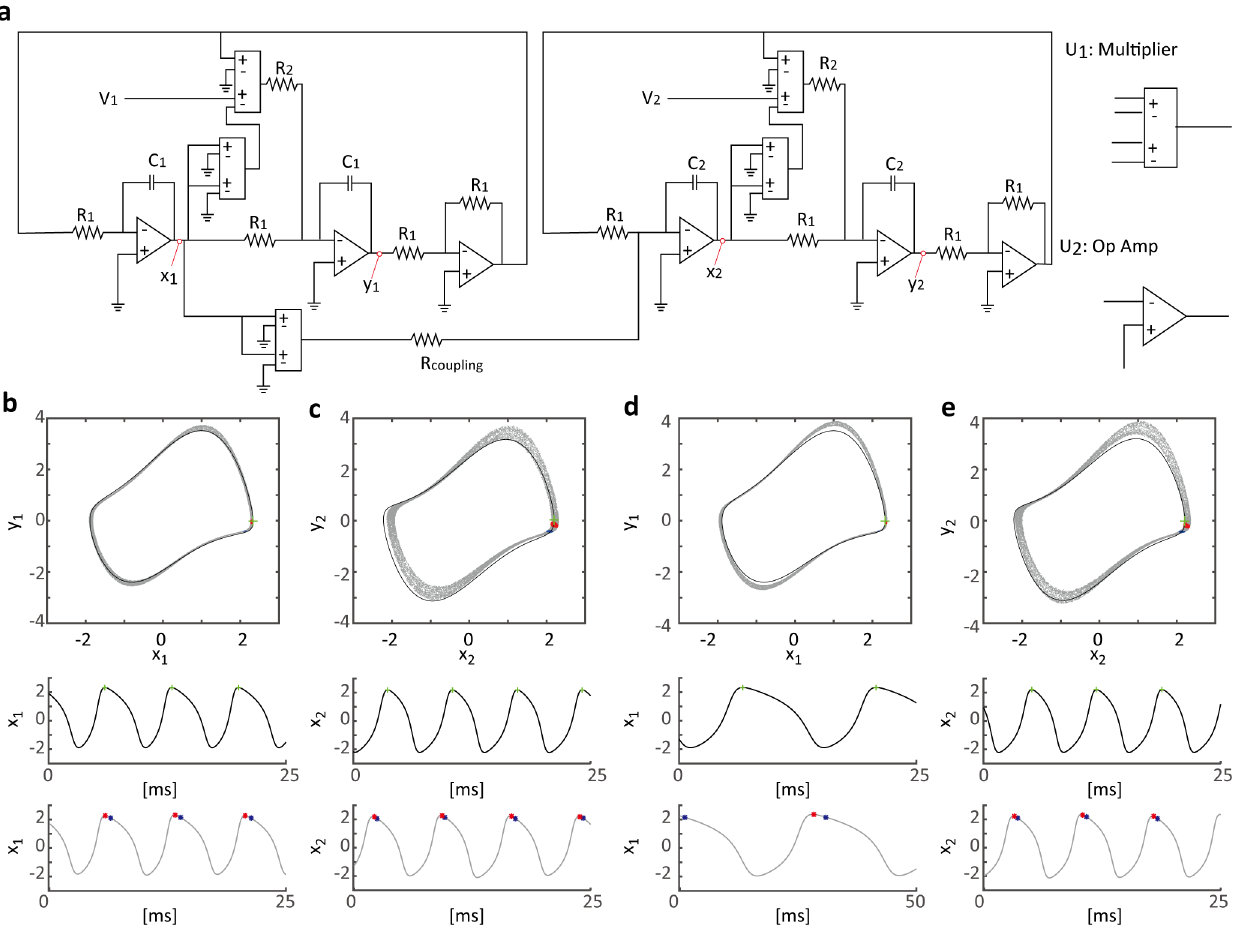
Fig 1. Electronic circuit of a pair of van der Pol oscillators and recorded electric potential. (a) Schematic of electronic circuit of two coupled van der Pol oscillators, where x and y are positions for recording electric potential, R denotes resistors, and C denotes condensers. Electronic units U 1 and U 2 i i k i represent the multiplier and operational amplifiers, respectively. R coupling is a resistor whose resistance is the parameter of the strength of connectivity. (b) Experimental data of electric potentials x 1 and y 1 show the limit-cycle oscillator under the same-frequency (129.1 Hz) coupling condition (gray dots and line). The black trajectory shows the theoretical value computed by the van der Pol oscillator Eqs (15–18). Here, the frequency is 142.1 Hz. Blue dots represent the zero-phase reference points on the experimental data, which were determined automatically via Hilbert transformation. Green crosses represent the theoretical zero-phase reference points defined as the peak points of x . Red dots denote the adjusted zero-phase reference points. (c) x 2 and y 2 i show the oscillators under the same-frequency oscillator condition. The frequency of the experimental data is 132.5 Hz and that of the theoretical trajectory is 146.4 Hz. (d) Recorded electric potentials show the slow limit-cycle oscillator under cross-frequency coupling conditions (experimental frequency, 64.1 Hz; theoretical frequency, 71.1 Hz). (e) x 2 and y 2 denote the fast oscillator (experimental frequency, 131.1 Hz; theoretical frequency, 146.4 Hz).